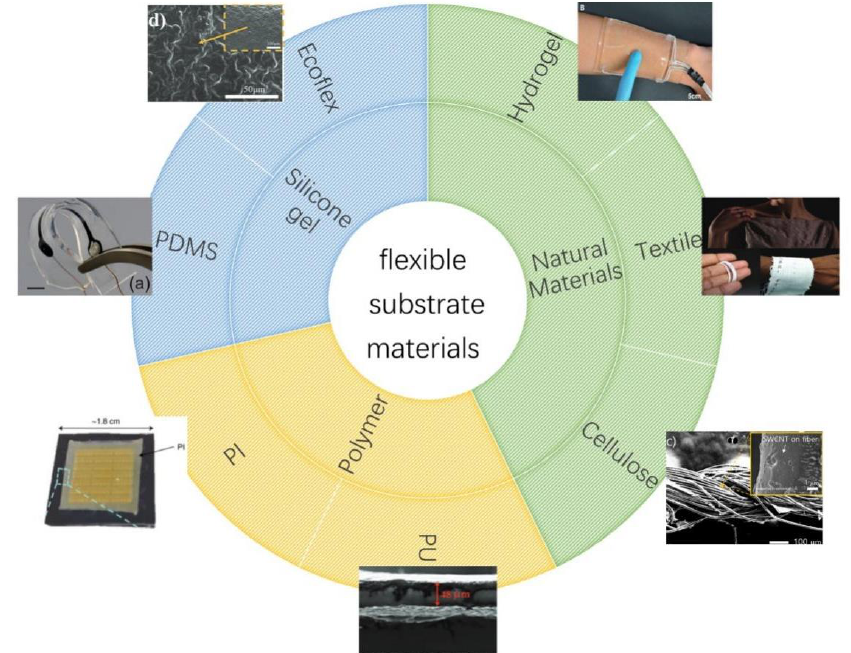
Figure 8. Flexible substrate materials for flexible wearable sensors, including microscopic image of Ecoflex with wavy texture structure, reprinted with permission from ref. [139]. Copyright 2021, Wiley. Integration of multi-walled carbon nanotubes and graphene nanosheets into PDMS, reprinted with permission from ref. [107]. Copyright 2013, Journal of Applied Physics. PI flexible material is covered on a Sio/Si substrate, reprinted with permission from ref. [140]. Copyright 2021, nature. Cross-sectional microscopic image of PU, reprinted with permission from ref. [141]. Copyright 2015, nature. Single-wall carbon nanotube-coated cotton thread, reprinted with permission from ref. [142]. Copyright 2018, American Chemical Society. Textile with LED embedded yarns, reprinted with permission from ref. [143]. Copyright 2018, Nature. Touch panel with hydrogel as the flexible substrate, reprinted with permission from ref. [144]. Copyright 2016, Science.